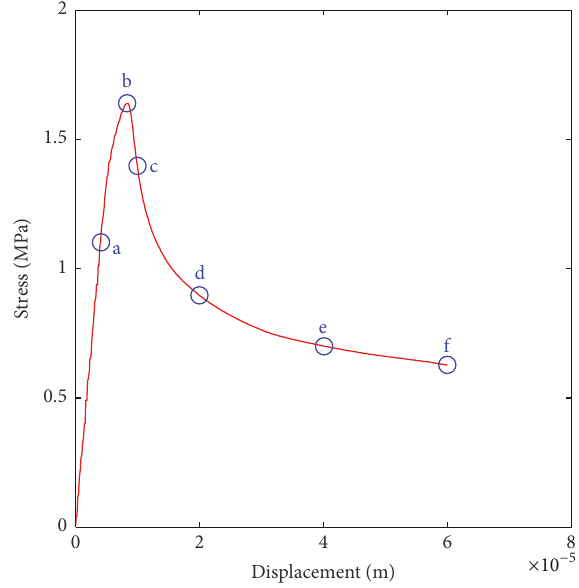
Figure 7: Stress-displacement curve ( 𝐴 𝐹 = 40 %, without